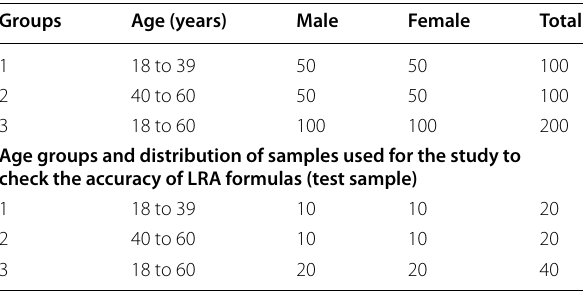
Table 1 Age groups and distribution of samples used for the study to derive the LRA formulas (reference